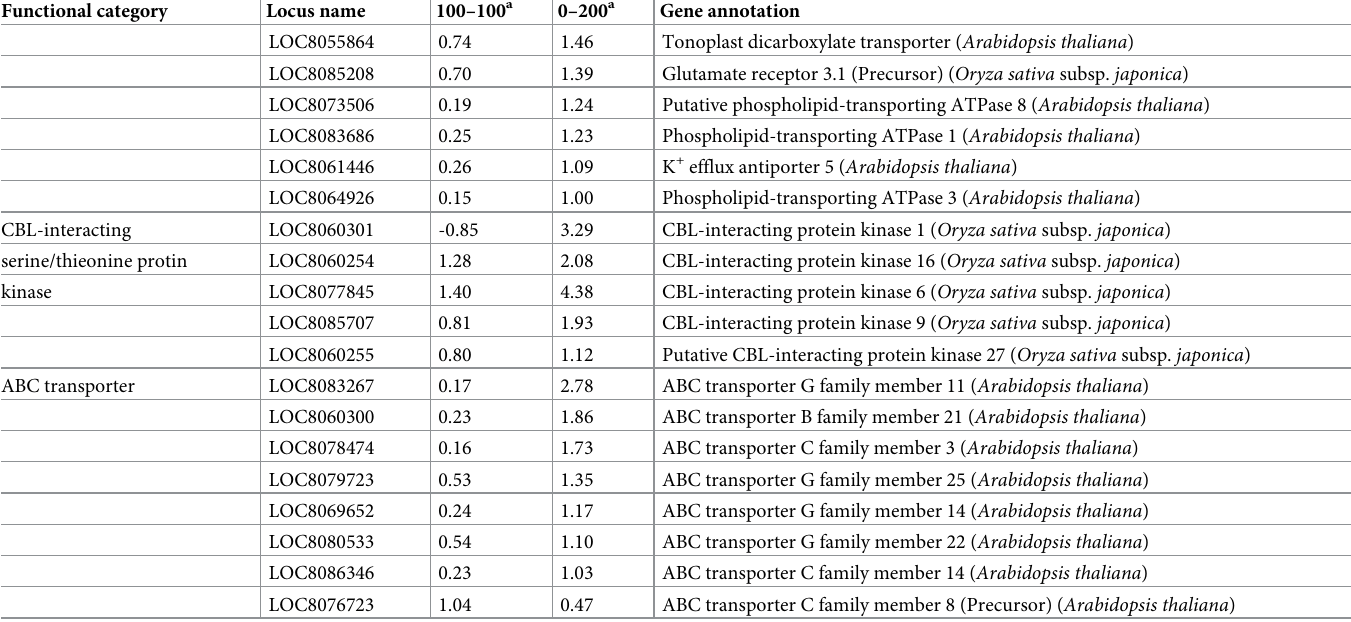
Similarly, the expression of genes encoding transporters of K + , nitrate, and phosphate was downregulated in both salinity treatments, whereas compared with that in both the high-saline side and the uniform salinity treatment, the expression in the NaCl-free side of the nonuni- form salinity treatment was upregulated ( Table 4 ). In response to salt stress, the expression levels of a number of TFs, for example, NACs, ERFs, WRKYs, MYBs, and bZIPs, changed. Spe- cifically, in the high-saline side in the nonuniform salinity treatment, the expression of most of